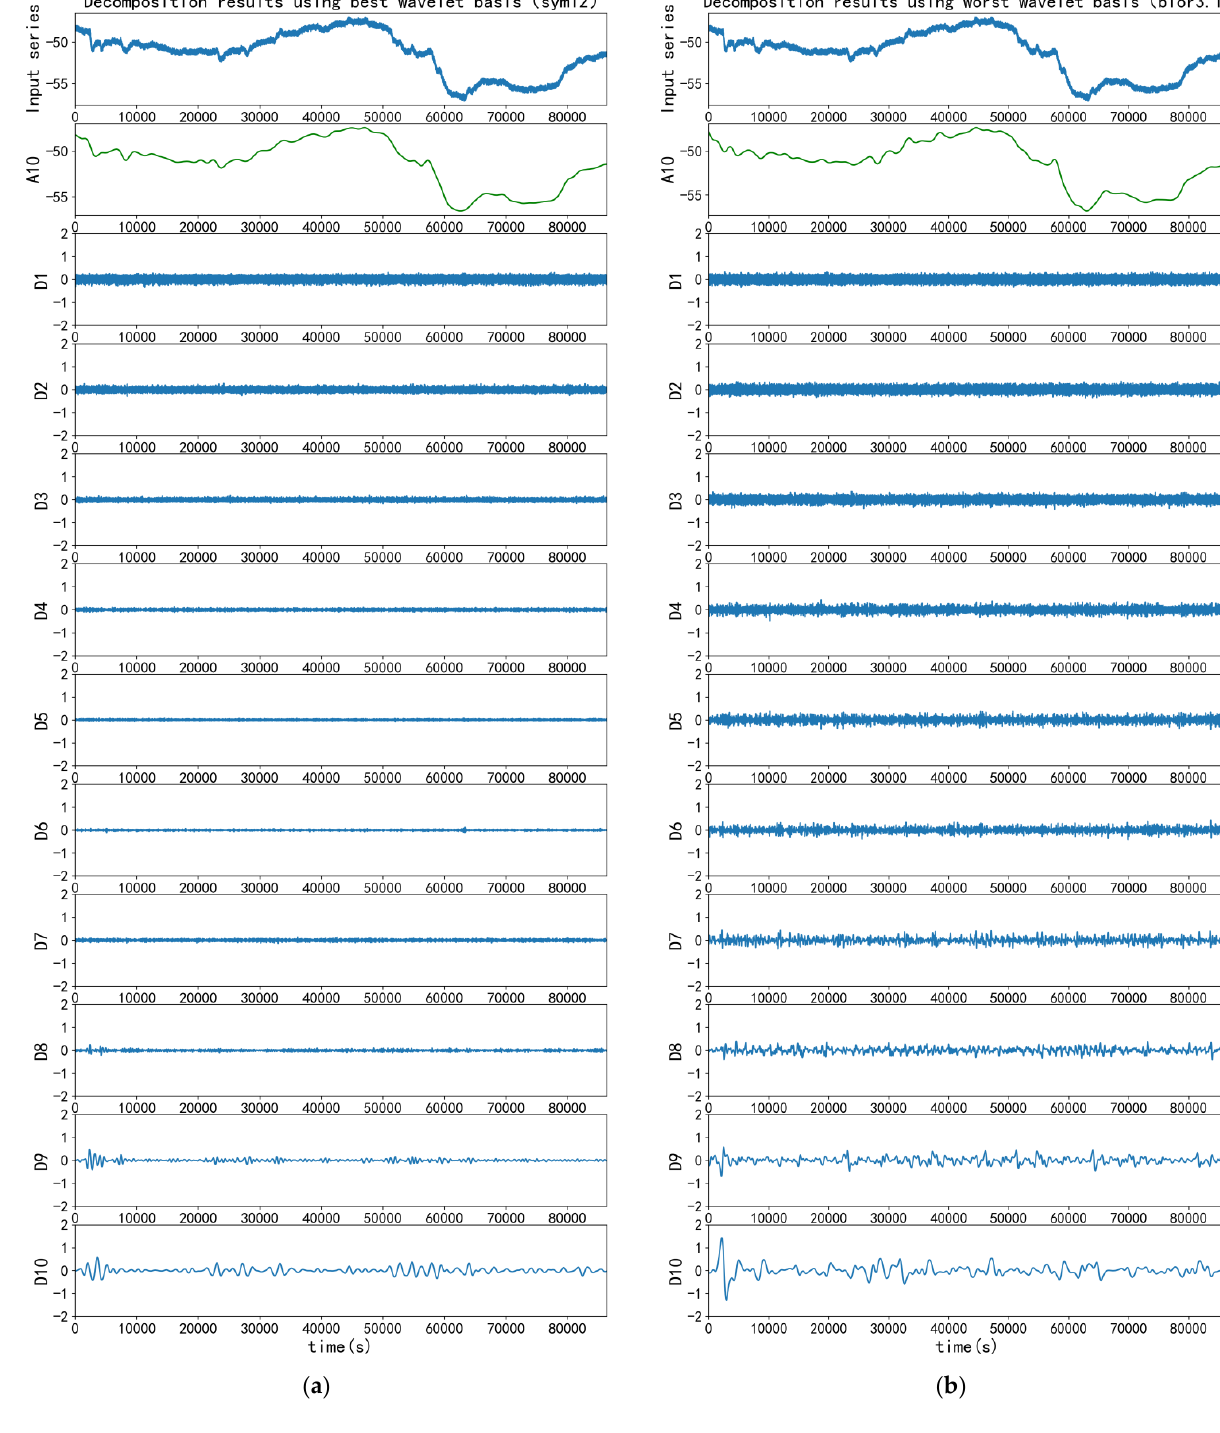
Figure 6. Decomposition results using best and worst wavelet basis: ( a ) Decomposition results using sym12; ( b ) Decomposition results using bior3.1.